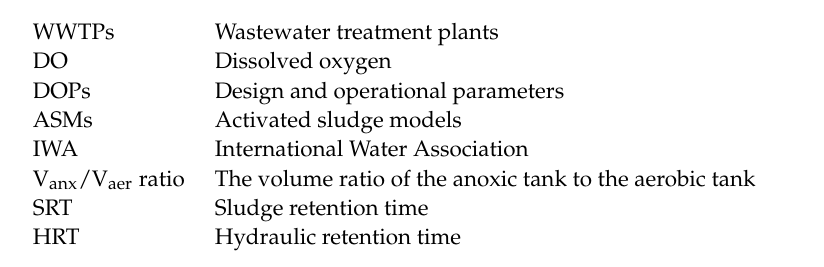
stoichiometric and kinetic parameters in the ASM2d concerning effluent quality based on lab-scale experiment, Table S8: Calculation formulas of the operating cost, Table S9: The result of ANOVA analysis for RE NH4 , Table S10: The result of ANOVA analysis for RE TN , Table S11: The result of ANOVA analysis for RE TP , Table S12: The result of ANOVA analysis for RE COD , Table S13: The result of ANOVA analysis for the operating cost, Table S14: Simulated results of RSM experiment based on Box–Behnken design for removal efficiencies of pollutants and the operating cost, Table S15: Regression quadratic equations for the studied responses, Table S16: ANOVA results for responding quadratic models, Table S17: Default and adjusted values of parameters in the ASM2d calibrated based on the pilot-scale AAO system, Table S18: Absolute t -value of the top 10 parameters that had significant influence on RE NH4 , RE TN and the operating cost, Text S1: Operation files of ANOVA analysis, Text S2: ANOVA analysis of regression quadratic equation obtained from RSM, Text